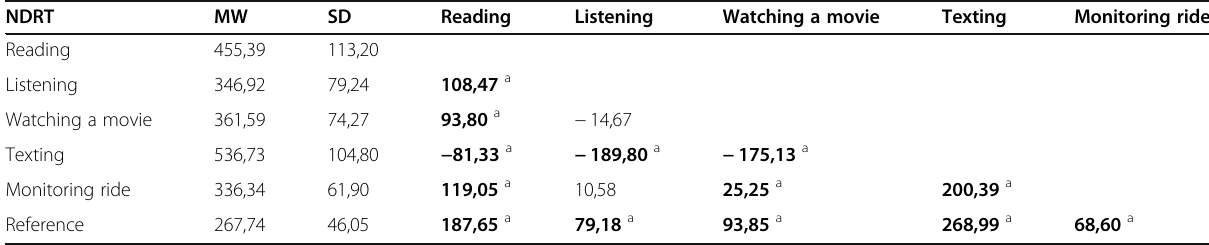
Table 3 Overview of the results DRT in ms